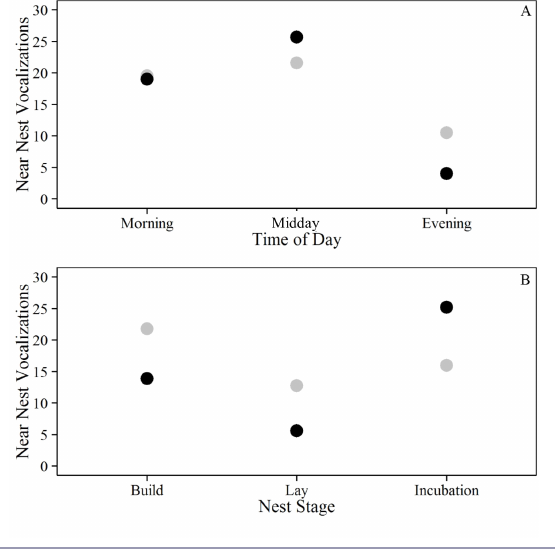
Fig. 3 . Predator-attraction hypothesis: parasitism fate. Interaction means from the best model of “near-nest” vocalizations by male vireos in central Texas, 2013–2014, considering parasitism fate (A) time of day and (B) nest stage. Vocalizations at nests that were eventually parasitized are indicated in black; vocalizations at nonparasitized nests are in gray. Standard errors are all too small to display accurately (all SE are w c i 0.00 † 1.00